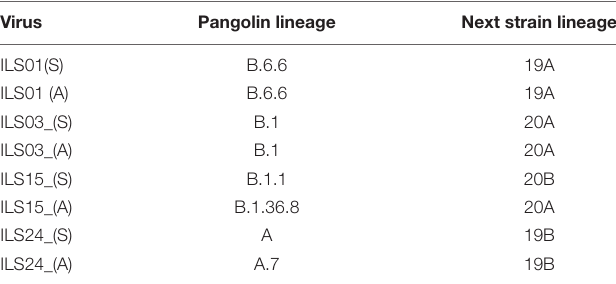
TABLE 5 | Tabular representation of the pangolin and next strain classification of the isolates and parent strains. Virus Pangolin